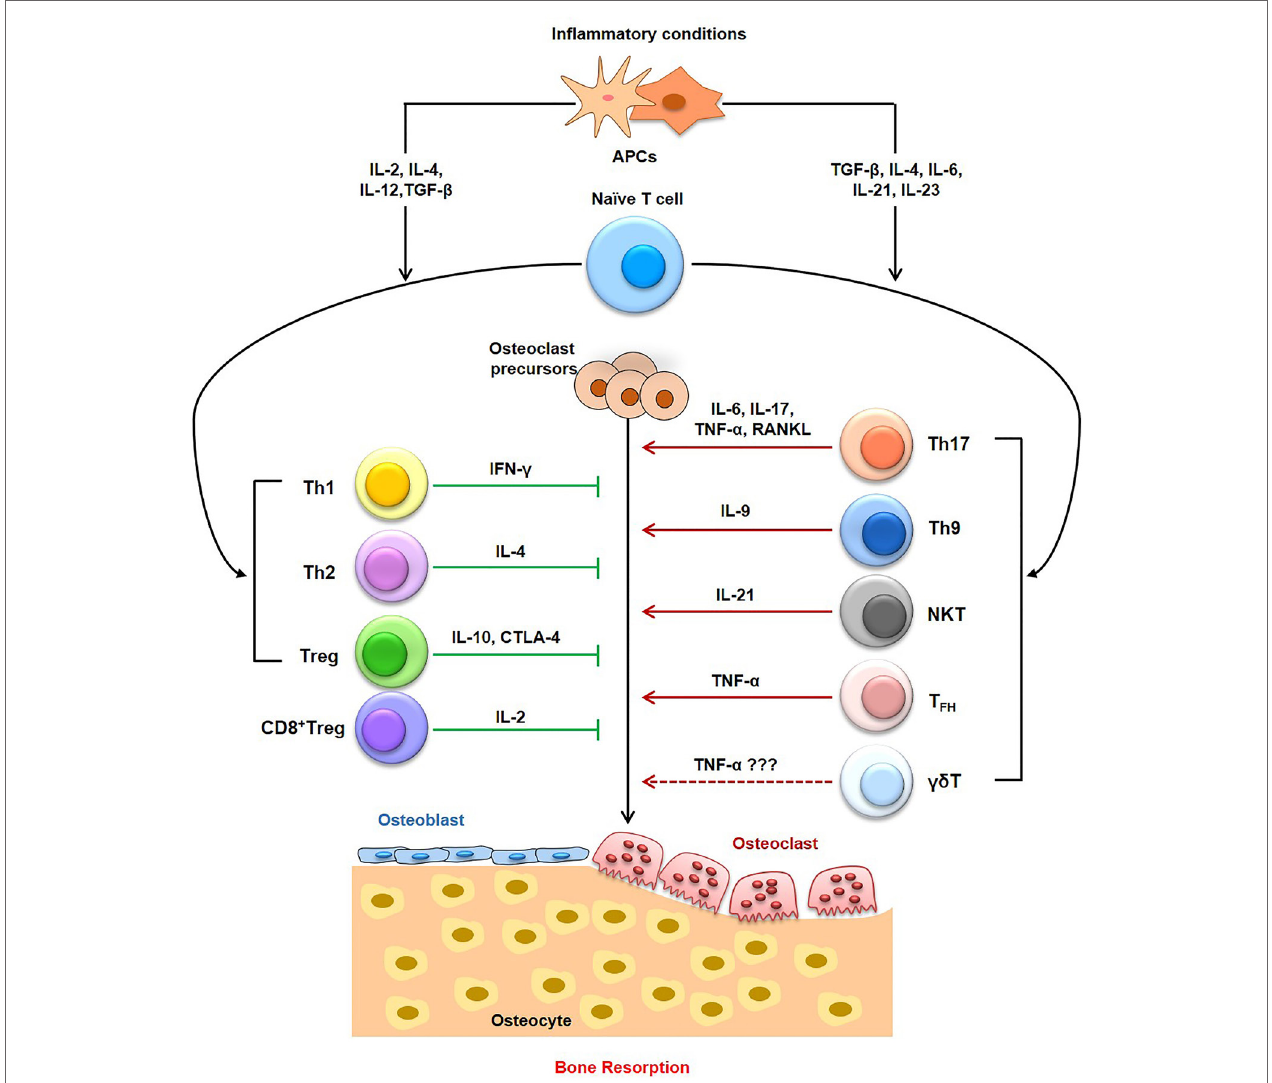
FigURe 3 | Role of T cells in Immunoporosis. T cells, including the T helper (Th) cells, cytotoxic T cells have pivotal role in the induction of osteoporosis-associated bone loss. Within T helper (Th) cells, Th9 cells, Th17 cells, NK T cells, and follicular helper T (T FH ) cells have been reported to enhance bone loss in osteoporosis. On the other hand, Th1, Th2, Tregs, and CD8T cells have been associated with osteoprotective properties, thereby inhibiting osteoporosis. The role of γδ T cells need more studies to relate them with